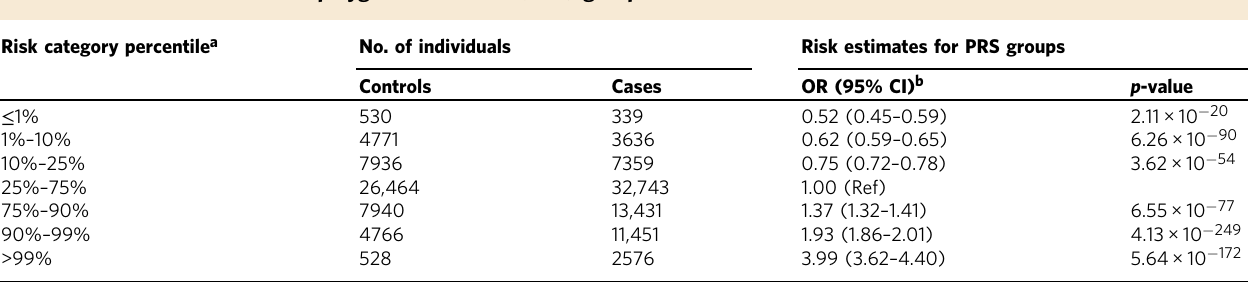
Table 2 Relative risk of PCa for polygenic risk score (PRS) groups